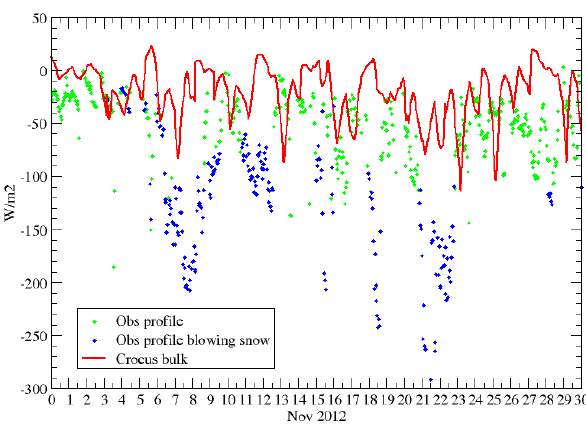
Figure 9. Surface latent heat flux in November 2012, evaluated from bulk parameterization in the Crocus model (red line) and from the profile method when blowing snow occurs (blue dots) or not (green